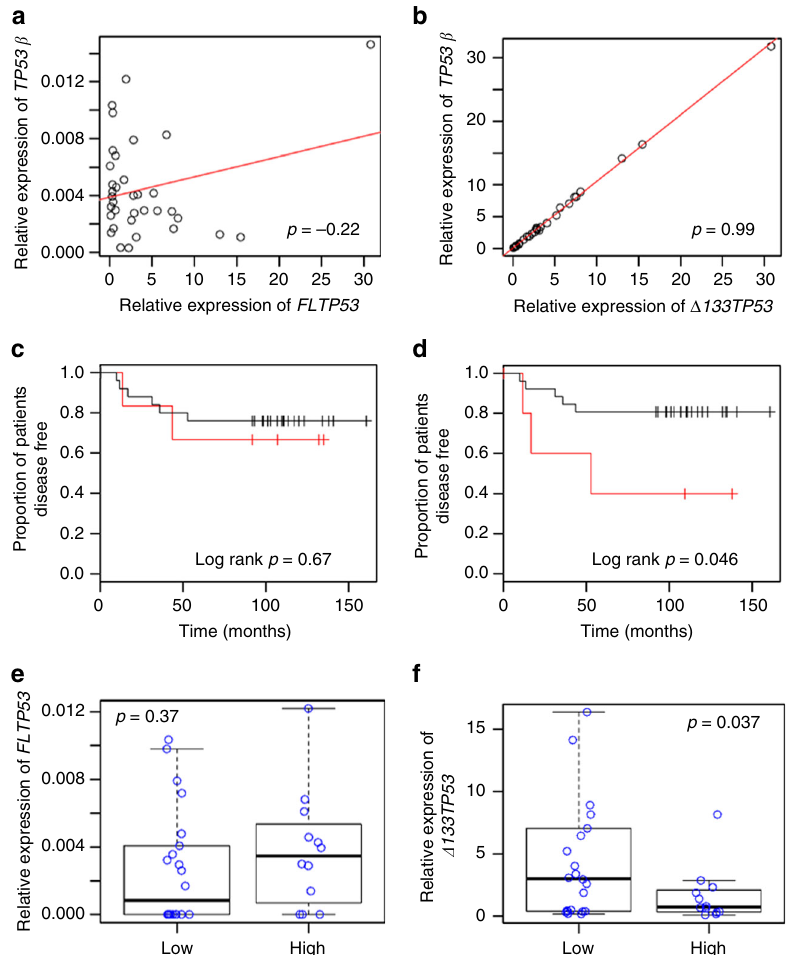
Fig. 7 Elevated Δ 133TP53 transcript in human colorectal cancer is associated with shorter disease-free survival. a Correlation of relative FLTP53 transcript and TP53 β transcript over the 35 tumours, R 2 = − 0.22. b Correlation of relative Δ 133TP53 transcript with TP53 β transcript across the 35 colorectal tumours, R 2 = 0.99. c Kaplan – Meier curves for 35 colorectal cancer patients illustrating the proportion of disease-free patients strati fi ed by tumours that have a relative FLTP53 transcript expression < 80th percentile (black) vs. those with relative FLTP53 transcript expression ≥ 80th percentile (red; log rank test p = 0.67). d Kaplan – Meier curves for 35 colorectal patients illustrating the proportion of disease-free patients strati fi ed by tumours that have a relative Δ 133TP53 transcript expression < 80th percentile (black) vs. those with relative Δ 133TP53 transcript expression ≥ 80th percentile (red; log rank test p = 0.046). e Distribution of relative FLTP53 transcript expression in 34 colorectal tumours strati fi ed by lymphocytic in fi ltration ( p = 0.37). f Distribution of relative Δ 133TP53 transcript expression in 34 colorectal tumours strati fi ed by lymphocytic in fi ltration ( p = 0.037). The line in the middle of each box represents the median, the top and bottom outlines of the box represent the fi rst and third quartiles. p -value ( e , f ) was obtained after performing a heteroscedastic, two-tailed unpaired t -test between different groups. p < 0.05 was considered signi fi